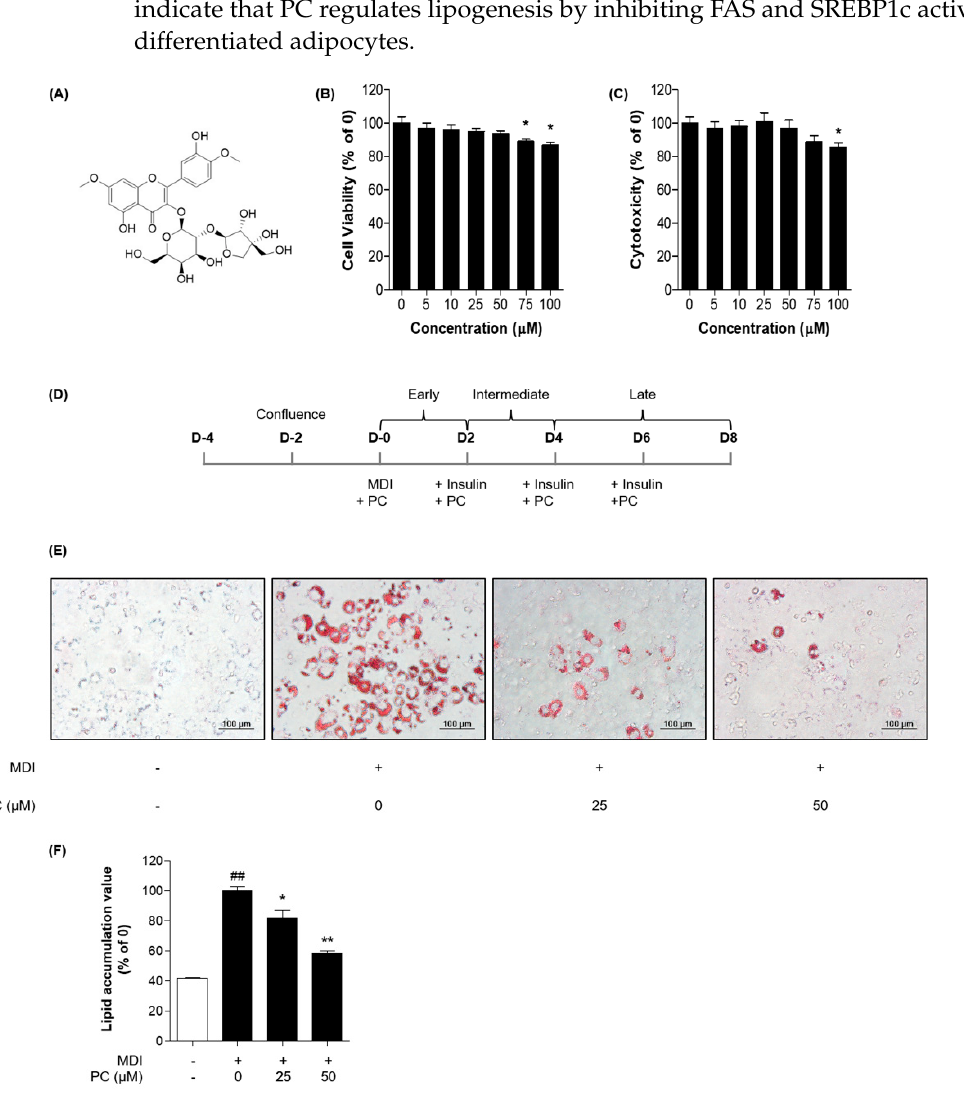
Figure 1. PC suppression of lipid accumulation in 3T3-L1 adipocytes: ( A ) Structure of PC; 3T3-L1 preadipocytes were treated with indicated concentrations of PC for 8 days, and cell viability was confirmed via the MTT assay ( B ) and LDH release assay ( C ); ( D ) Scheme of the 3T3-L1 cell differentiation experiment; 3T3-L1 cells were treated with PC for 8 days and then stained with Oil Red O. Lipid droplets were visualized ( E ) and quantified ( F ); The image data was photographed using an Olympus IX71 microscope (magnification: 200×, scale bar: 100 μ m). The experimental data were obtained from at least three independent experiments and shown as means ± standard errors of the means. ## p < 0.01 compared to the control (non-treated) group. * p < 0.05 and ** p < 0.01 compared to the MDI-treated group.